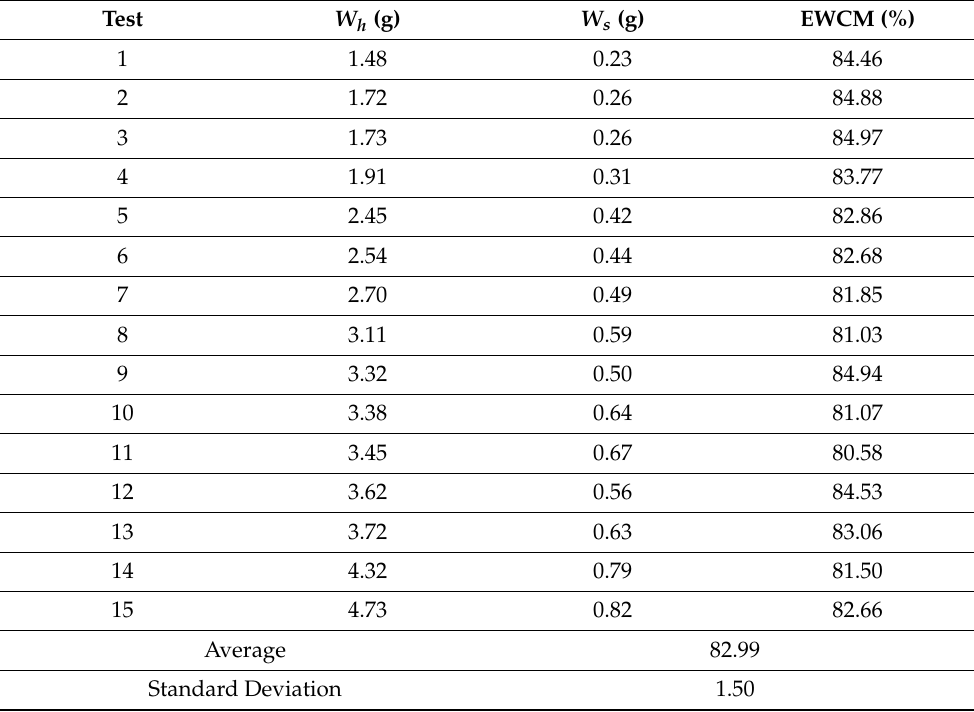
Table 1. Water content measurements of dry and hydrated samples at different